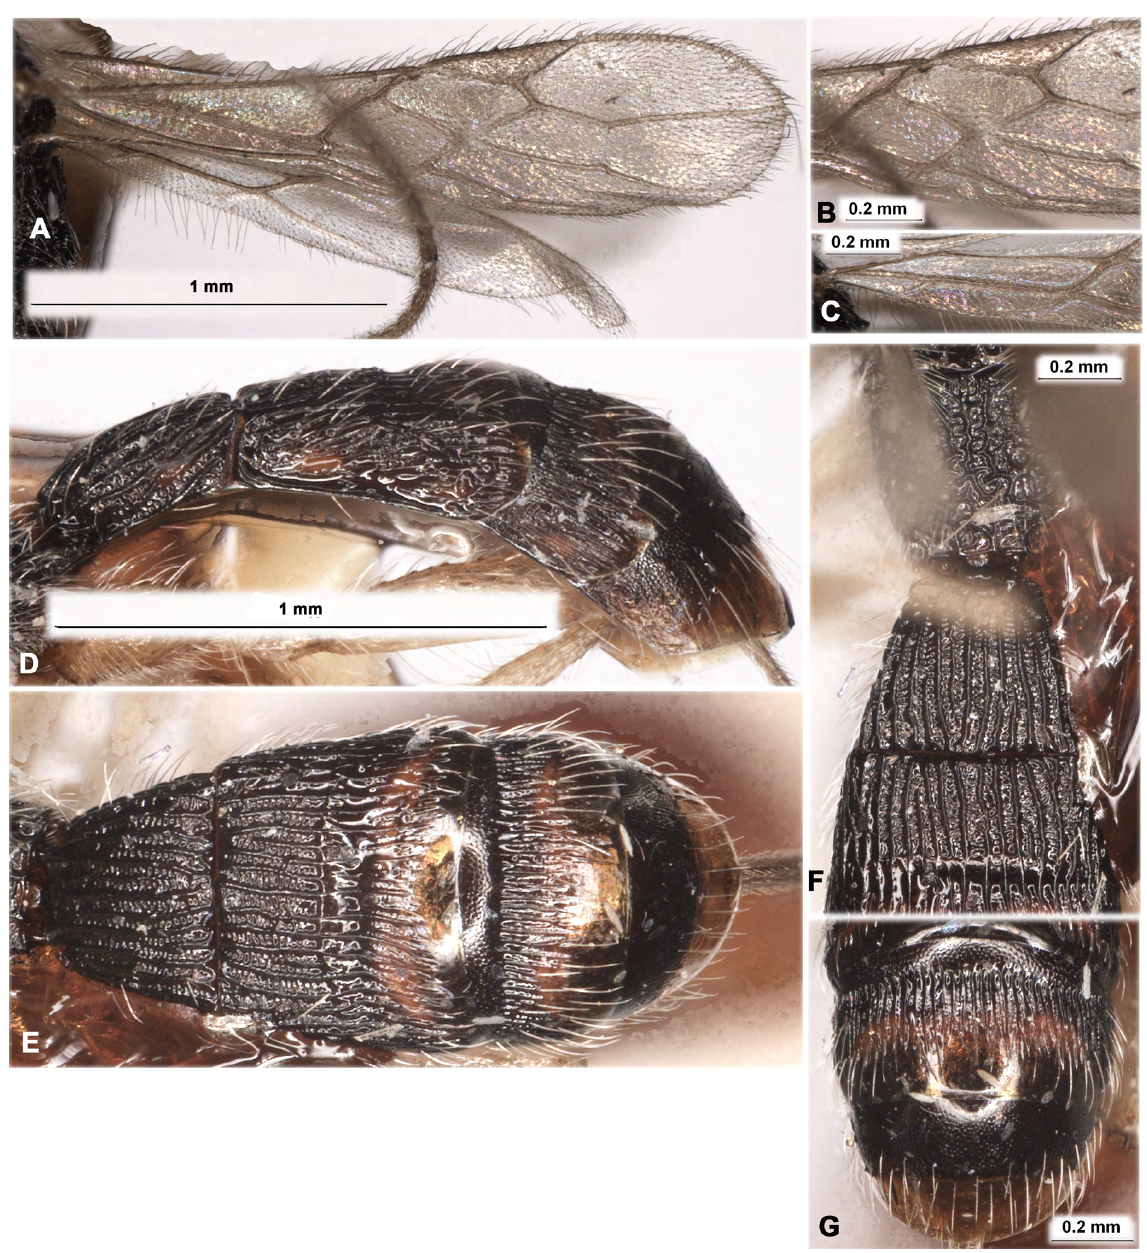
Fig. 48. Rhaconotus ( Pararhacon ) haeselbarthi Belokobylskij, 2005, ♀, holotype, SSMG. A . Wings. B . Median part of fore wing. C . Basal part of hind wing. D . Metasoma, lateral view. E . Metasoma, dorsal view. F . Propodeum and first to second metasomal tergites, dorsal view. G . Apex of metasoma, dorsal